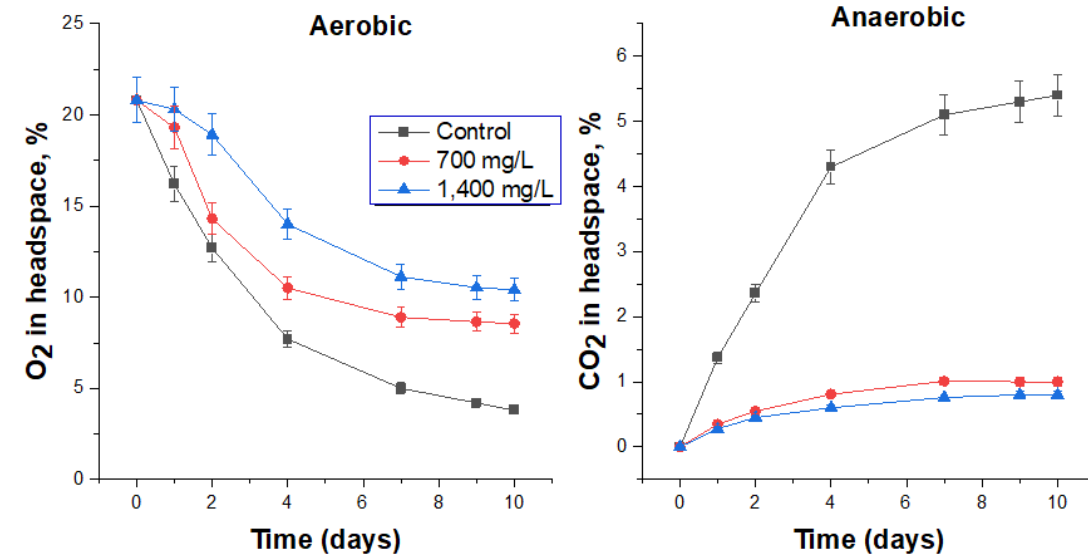
Figure 6. The effect of “Latrina” on O 2 consumption under aerobic conditions and CO 2 production under anaerobic conditions by the respective microbial communities in FS.